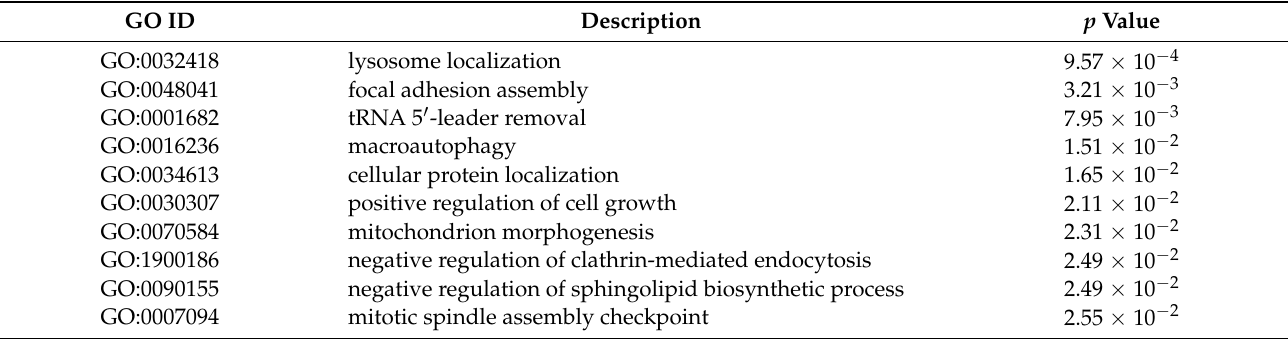
Table 3. The top 10 GO terms that were enriched in 2D